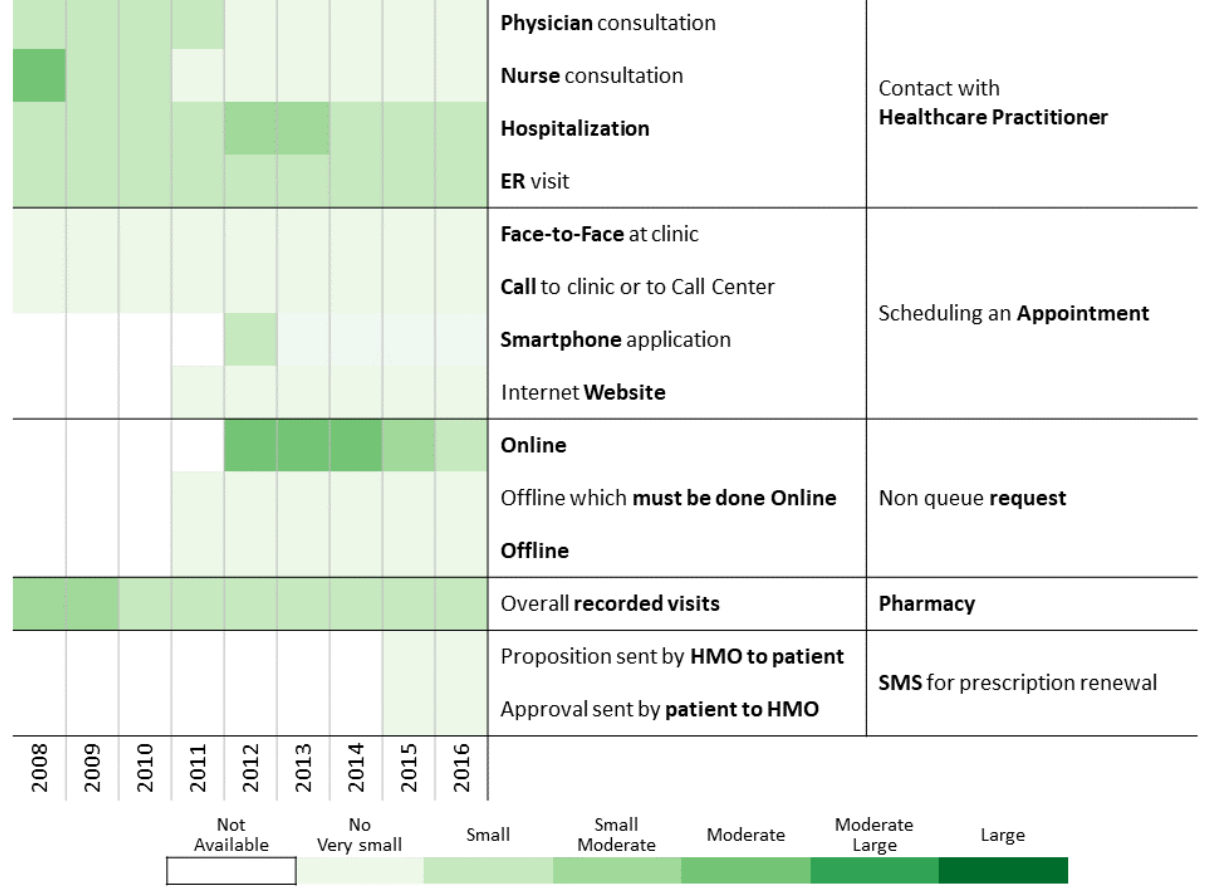
Figure 8. Communication pattern changes between 2008 and 2016 for the relatively low contacts — non–clinic-based